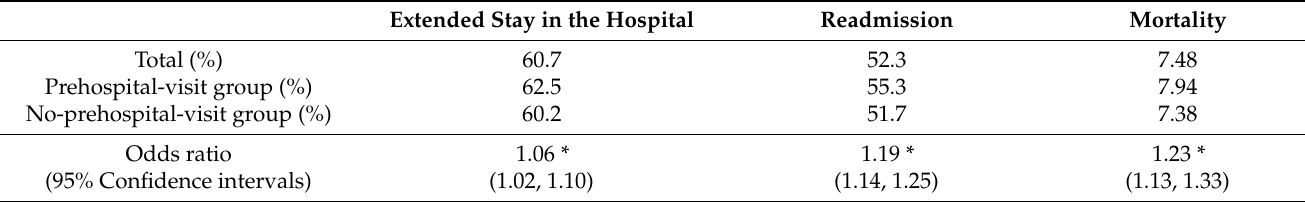
Table 2. Health outcomes of acute stroke patients according to prehospital